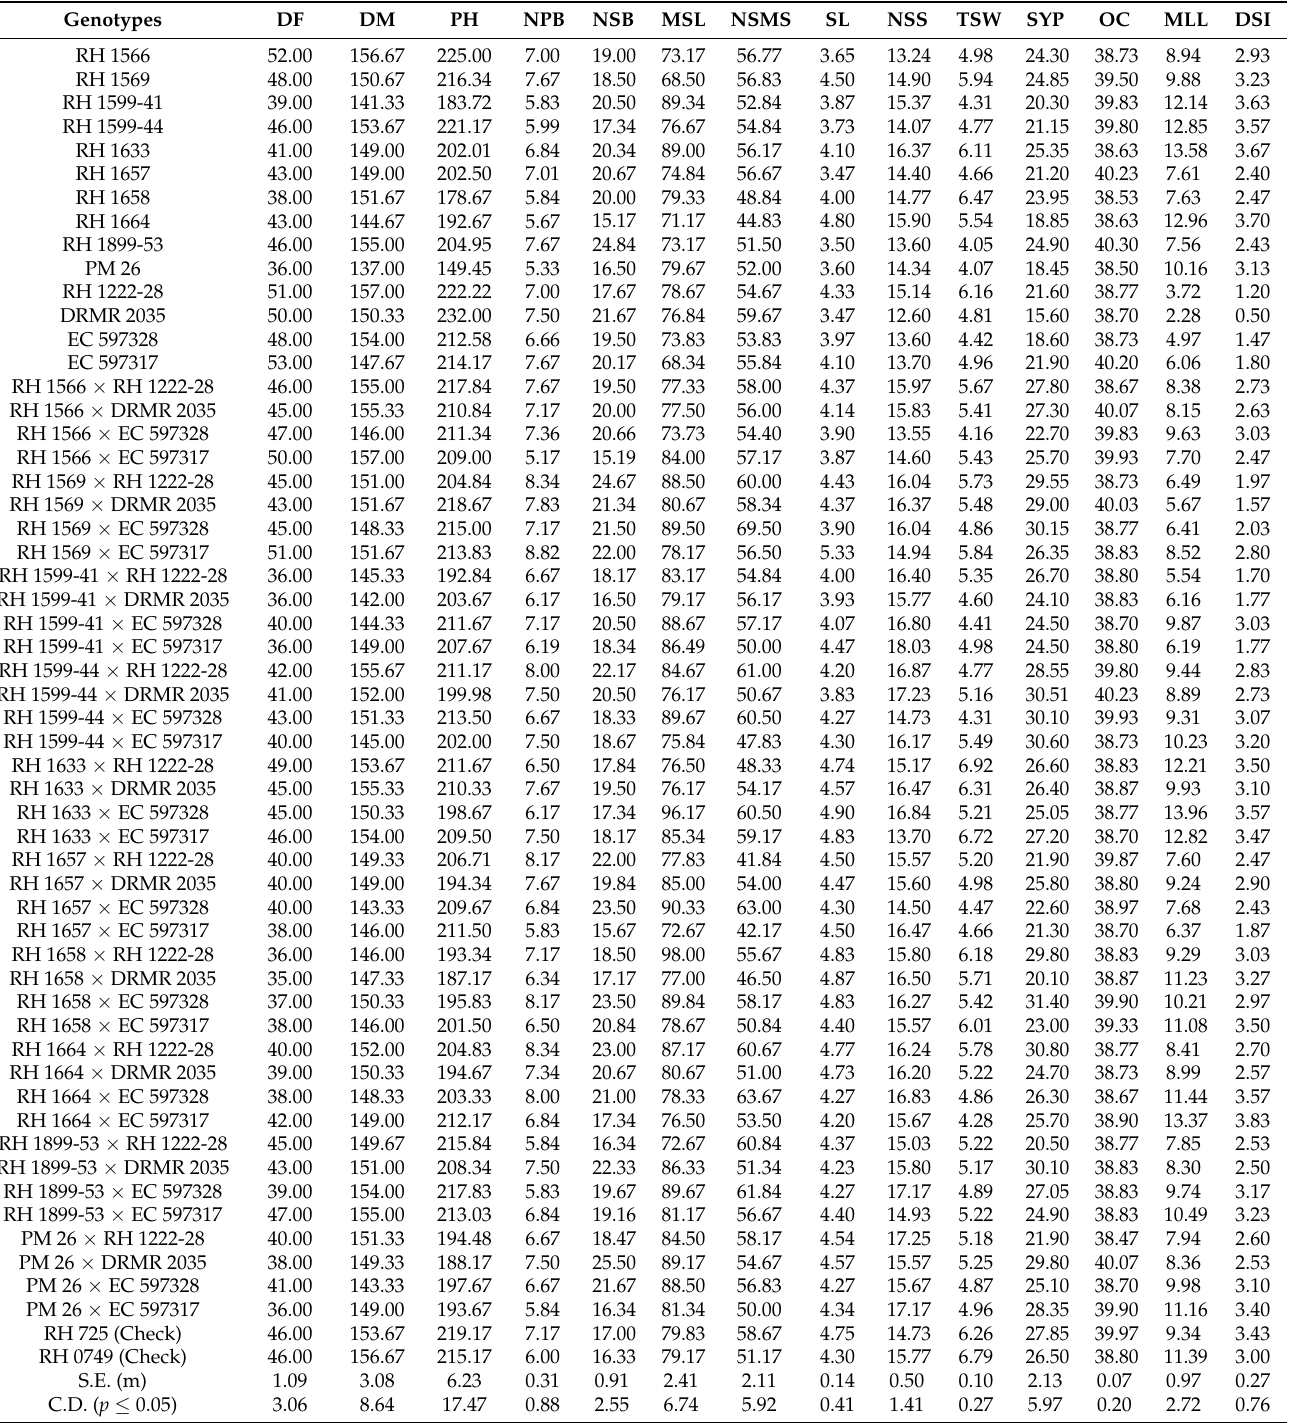
Table 3. Mean performance of parents and their F 1 hybrids for Sclerotinia stem rot resistance assessment parameters as well as seed yield and its component